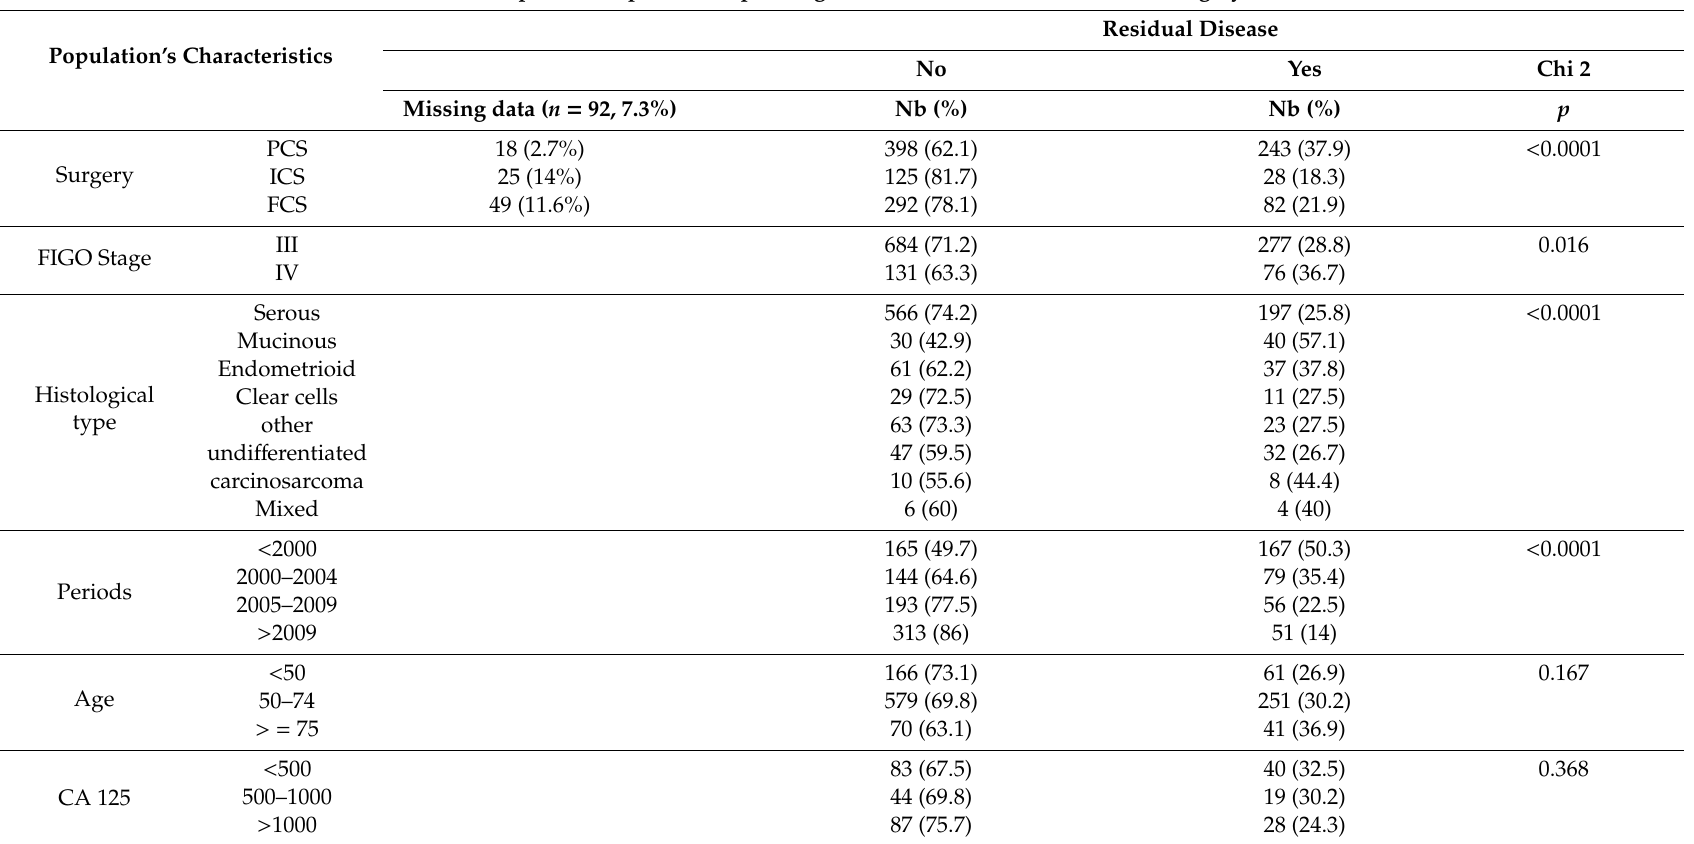
(b) Comparison of patients depending on residual disease at the end of